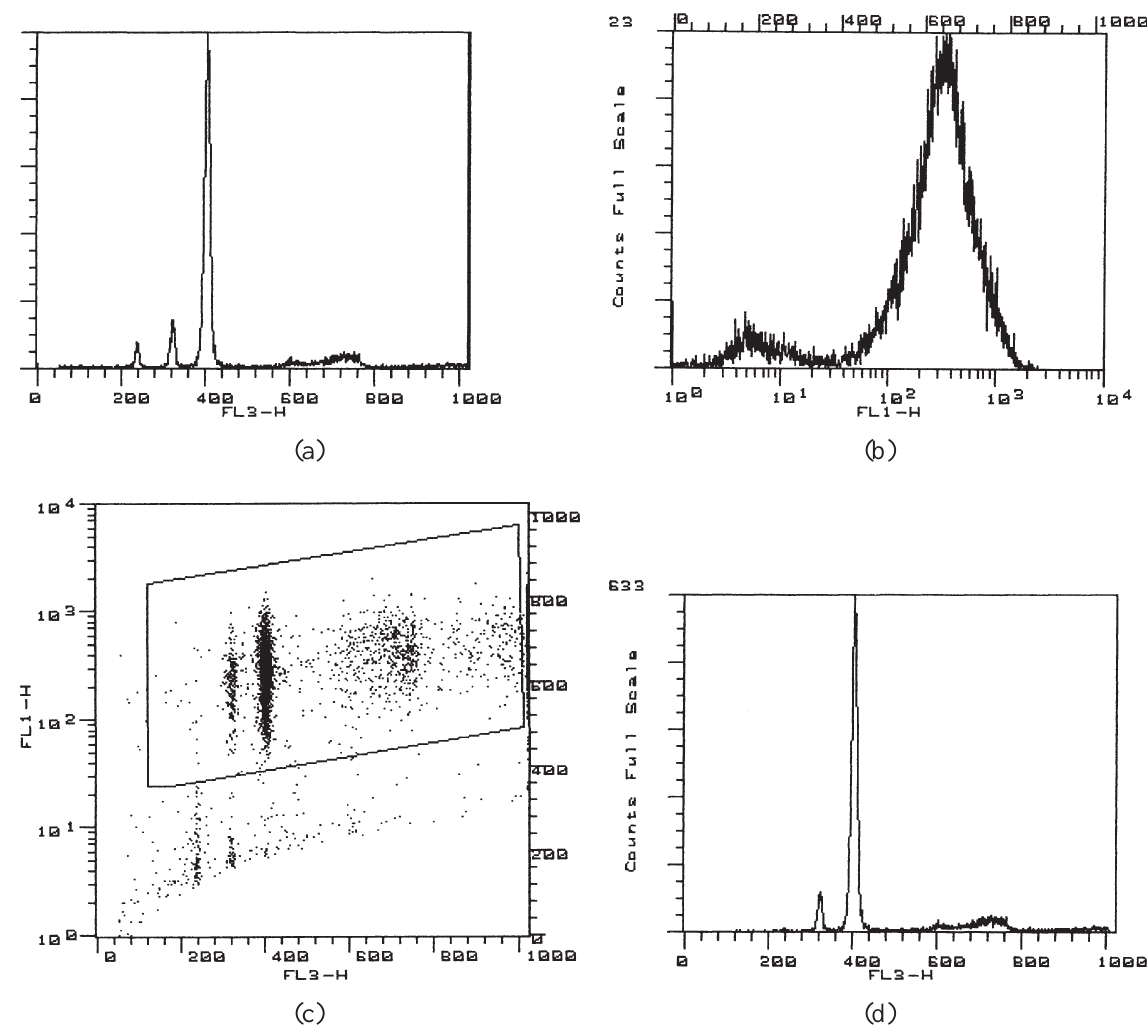
Fig. 5. (a) Ungated DNA histogram of a breast carcinoma with two abnormal DNA stemlines (DIs = 1.25 and 1.70) and a population of cells with a normal DNA content; (b) histogram of green fluorescence (FL1-H) of cytocheratin labelled cells which shows two well separated peaks, relative to negative and positive immunolabelled cell populations; (c) dot plot with red fluorescence on the X axis and green fluorescence on the Y axis for dual labelled samples. CK-labelled cells were gated to generate a histogram (d) from the epithelial component only. Note the absence of a diploid peak, probably composed by inflammatory and stromal